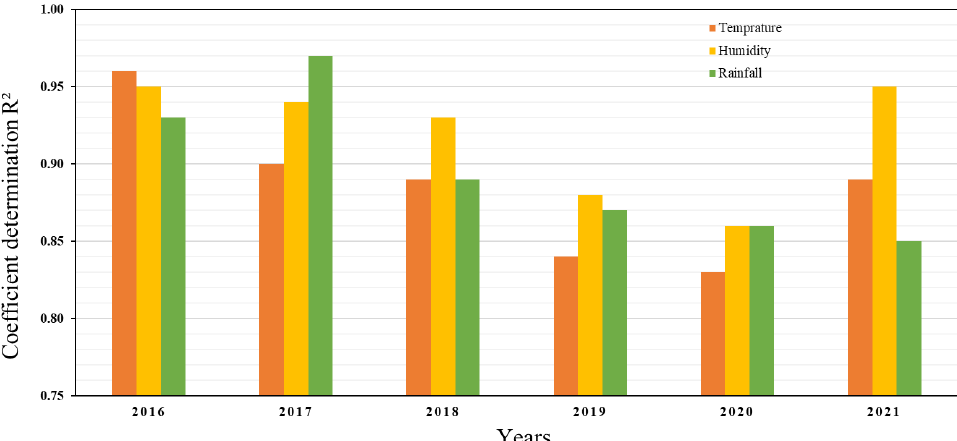
Figure 8. Coefficient is calculated between NDVIs and climate parameters for the years 2016–2021.